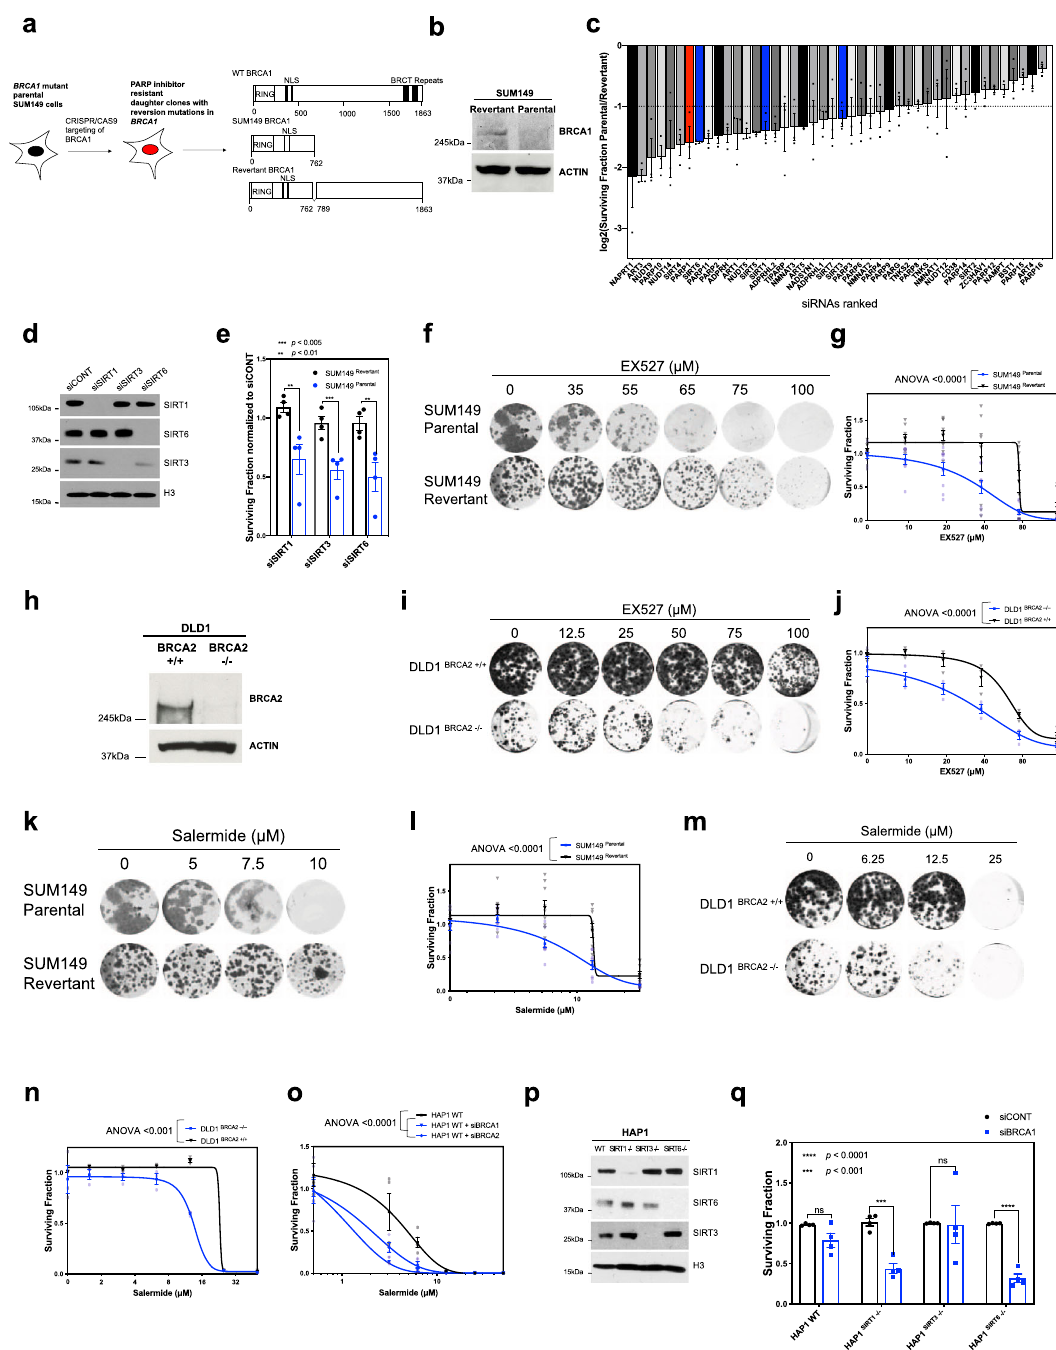
(Fig. 1f, g, SUM149 Parental SF 50 = 37 μ M, SUM149 Revertant SF 50 = 66 μ M, ANOVA p < 0.0001) and BRCA2 synthetic lethality in BRCA2 isogenic DLD1 cells 44 (Fig. 1h – j, DLD1 DLD1 BRCA2 – / – SF 50 = 30 μ M , BRCA2 + / + SF 50 = 57 μ M, ANOVA p < 0.0001). Synthetic lethality was also reproduced with a different sirtuin inhibitor, salermide 45 (IC 50 = 70 μ M for SIRT1, in vitro IC 50 for SIRT3 or SIRT6, not known) (Fig. 1k, l, SUM149 Parental SF 50 = 6 = 12 μ M, ANOVA p < 0.0001; Fig. μ M, SUM149 Revertant SF 50